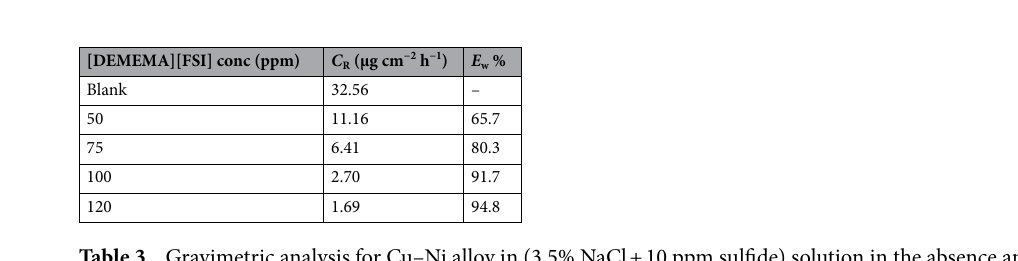
Table 3. Gravimetric analysis for Cu–Ni alloy in (3.5% NaCl + 10 ppm sulfide) solution in the absence and presence of [DEMEMA][FSI] at 298 K.